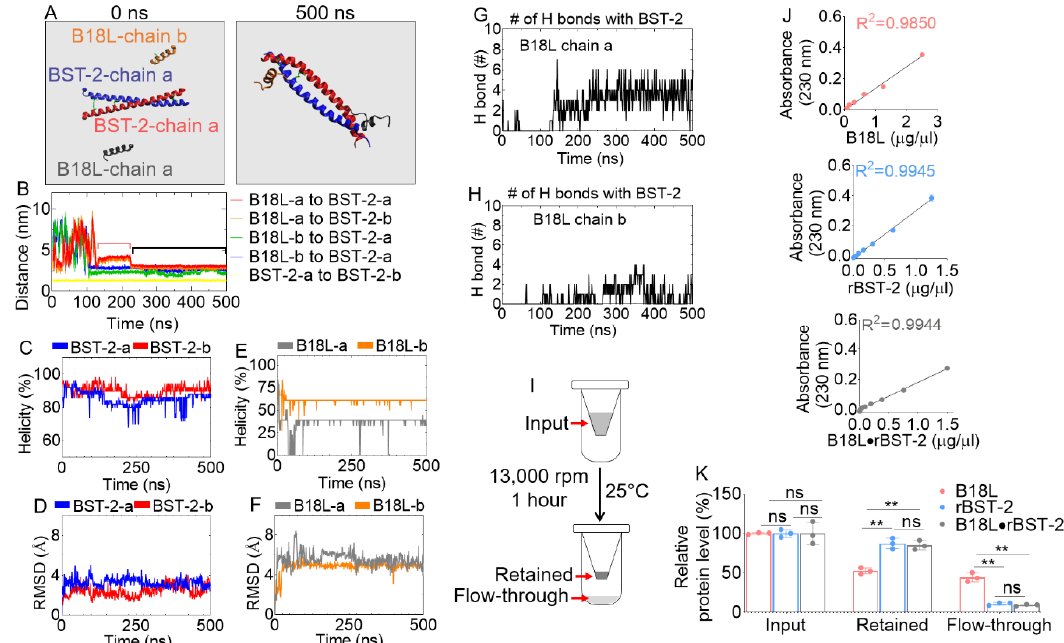
Figure 2. Interaction of B18L with BST-2: ( A ) Initial (t = 0, left) and final (t = 500 ns, right) snapshots of two B18L chains with BST-2 protein. ( B ) Evolution of center of mass (COM) distance between each chain in the MD system. Pink and black brackets represent two different binding positions. ( C ) Helicity and ( D ) RMSD of BST-2 as a function of time. ( E ) Helicity and ( F ) RMSD of B18L as a function of time. ( G ) Formation of hydrogen bonds as a function of time for B18L chain a with BST-2. ( H ) Formation of hydrogen bonds as a function of time between B18L chain b and BST-2. ( I ) Schematic of in vitro B18L•BST-2 interaction in vitro assay. ( J ) Standard curve used for protein concentration extrapolation from UV absorbance analysis. Linear regression and R-square values were obtained from the GraphPad Prism analysis. ( K ) Compound concentrations following extrapolation from UV absorbance. Unpaired t-test with Welch’s correction was used to determine the differences between the treatments. ** p < 0.01 and ns = not significant. B18L-a is the same as B18L chain a, B18L-b is the same as B18L chain b; same for BST-2-a and BST-2-b. Experiment was repeated at least three times, with similar results.